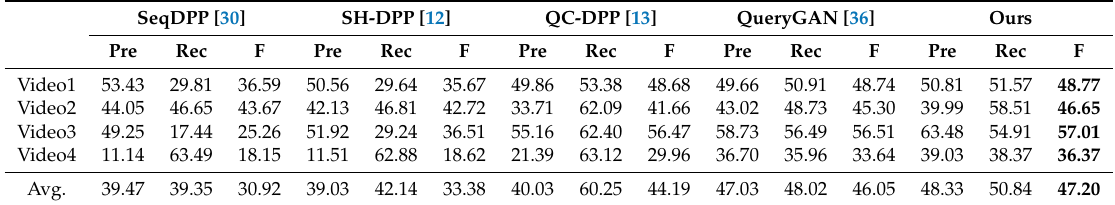
Table 1. Comparison of our proposed algorithm to the state-of-the-art methods for query-conditioned video summarization in terms of Precision (Pre), Recall (Rec) and F-measure (F). The best results (F-measure) are highlighted in bold.